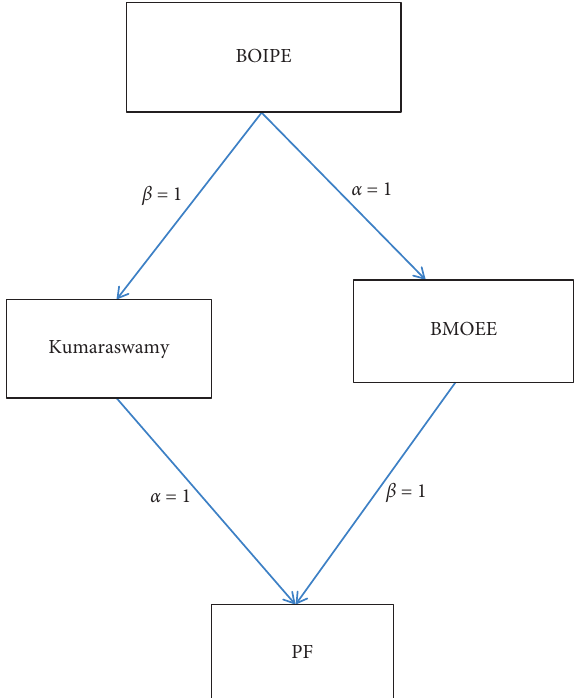
Figure 1: Submodels of BOIPE distribution.